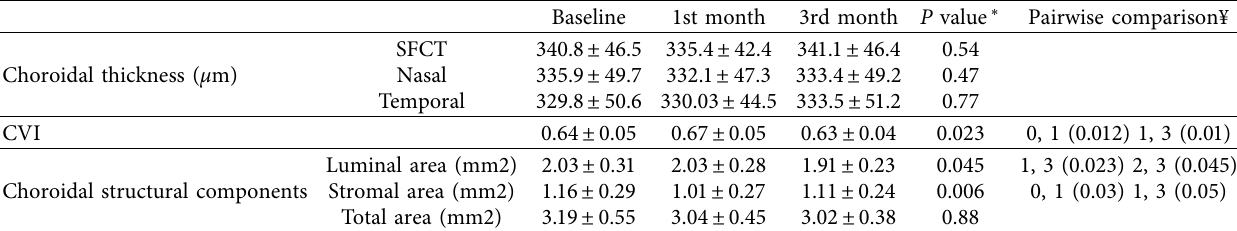
Table 2: Choroidal parameter over the study